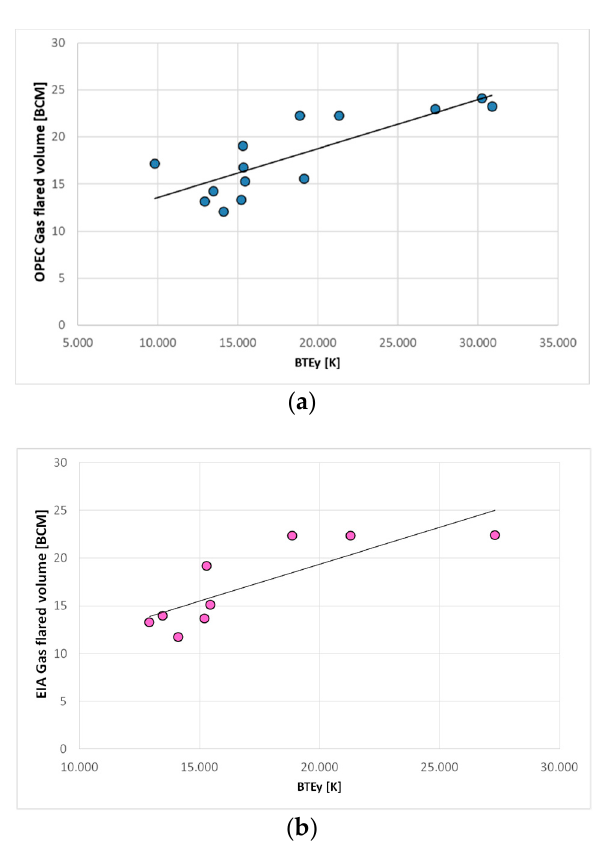
Figure 9. Plots of the linear regression models generated by exploiting ( a ) OPEC and ( b ) EIA dataset.